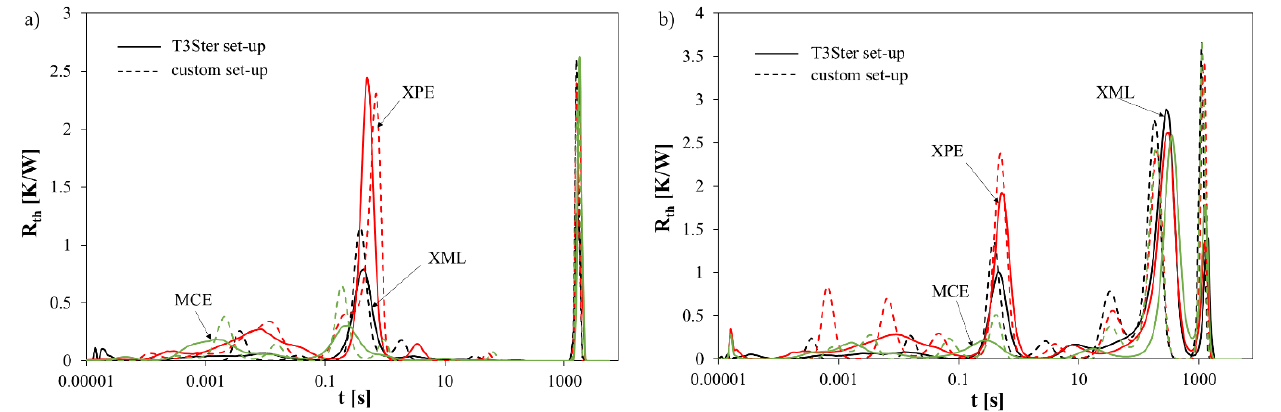
Figure 6. Spectra of thermal time constants of the tested light emitting diodes (LEDs) situated on the heat-sink ( a ) and operating without any heat-sink ( b ).